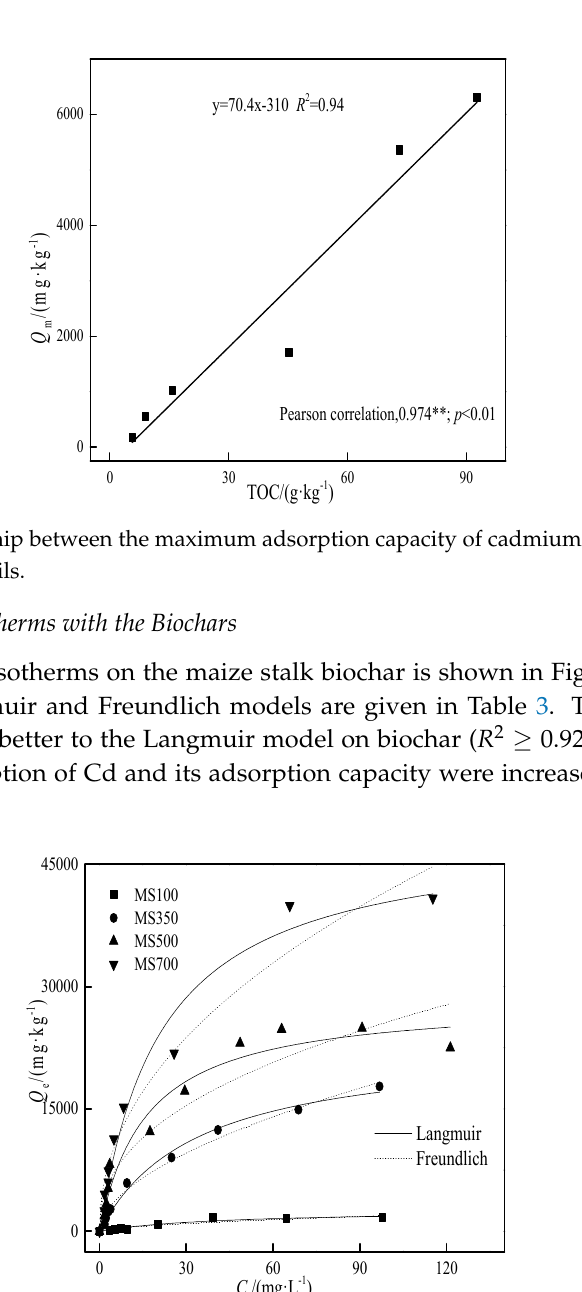
Figure 4. The Cd adsorption isotherms on the six selected soils.